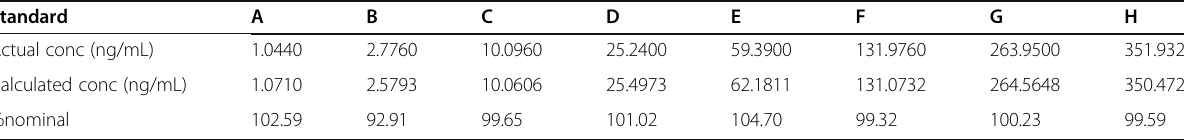
Table 9 Ruggedness (MTR-BA-LC-MS/MS-05)